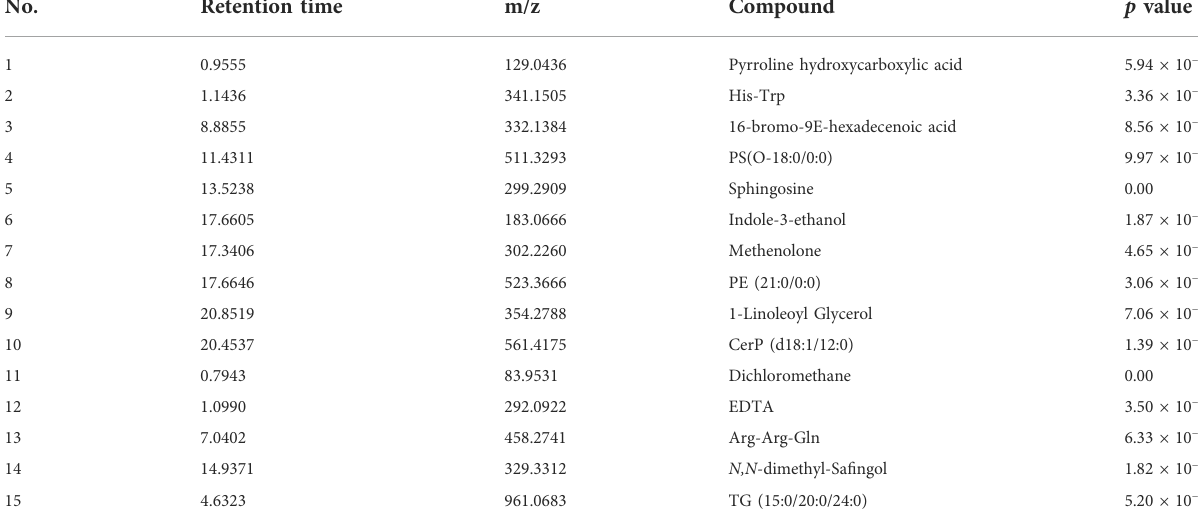
TABLE 2 Differential compounds of healthy volunteers and patients before HAART